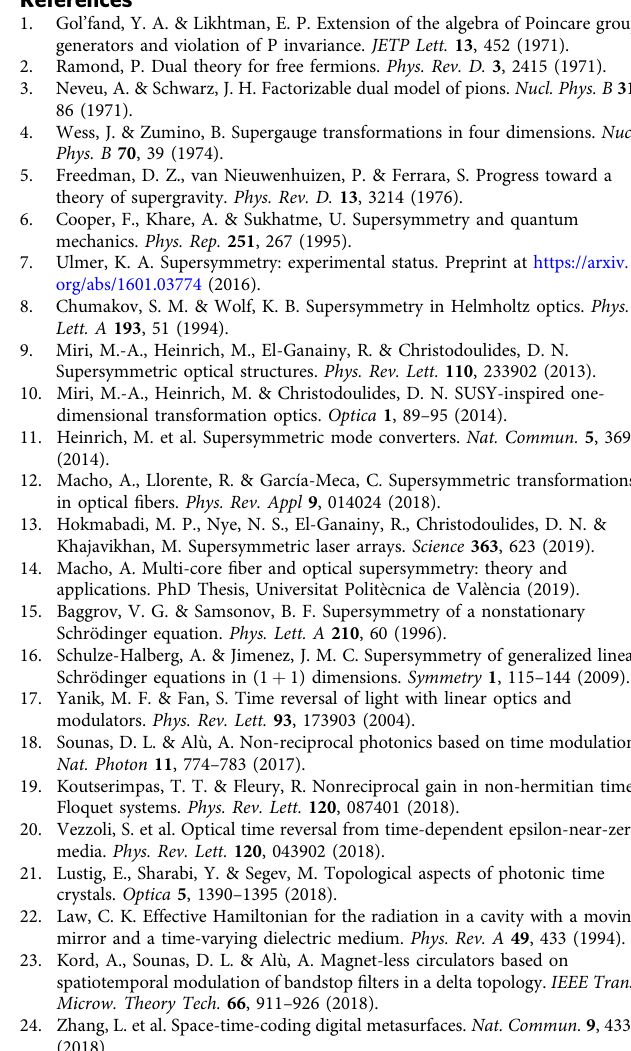
Code availability